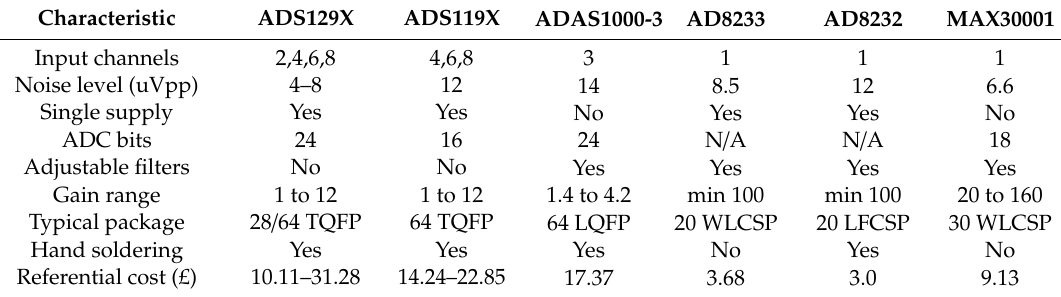
Table 1. Commercially available ECG front-end